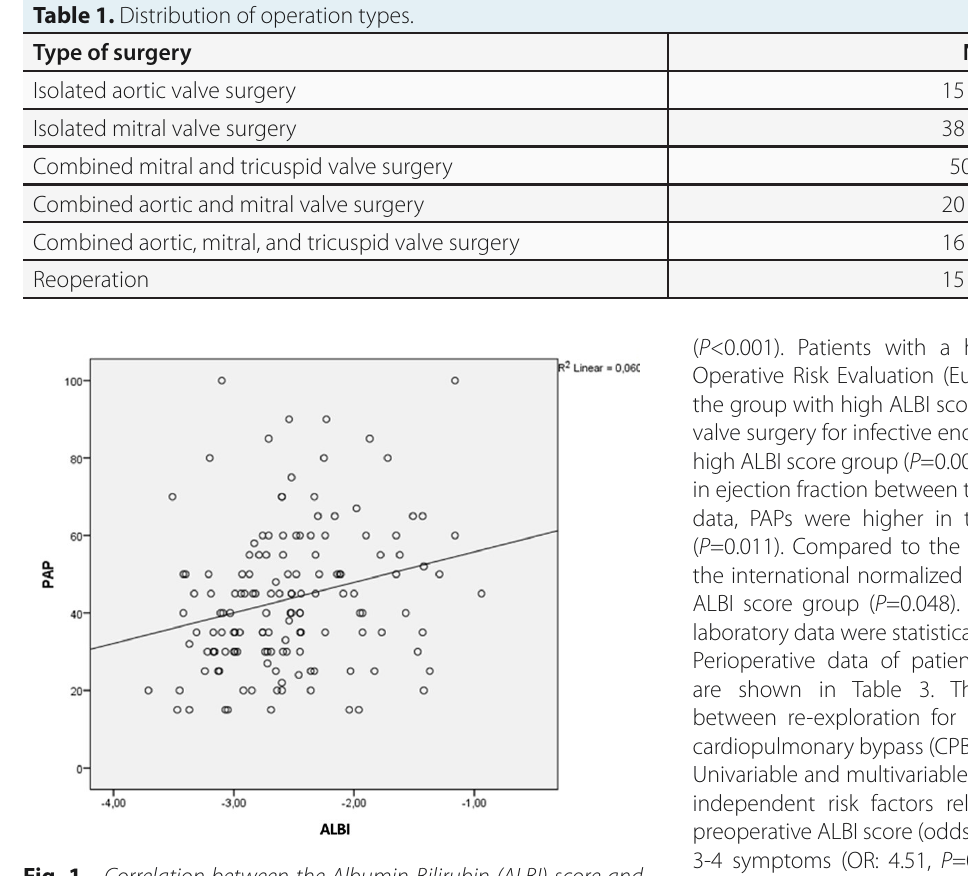
Fig. 1 - Correlation between the Albumin-Bilirubin (ALBI) score and the pulmonary artery pressure (PAP).